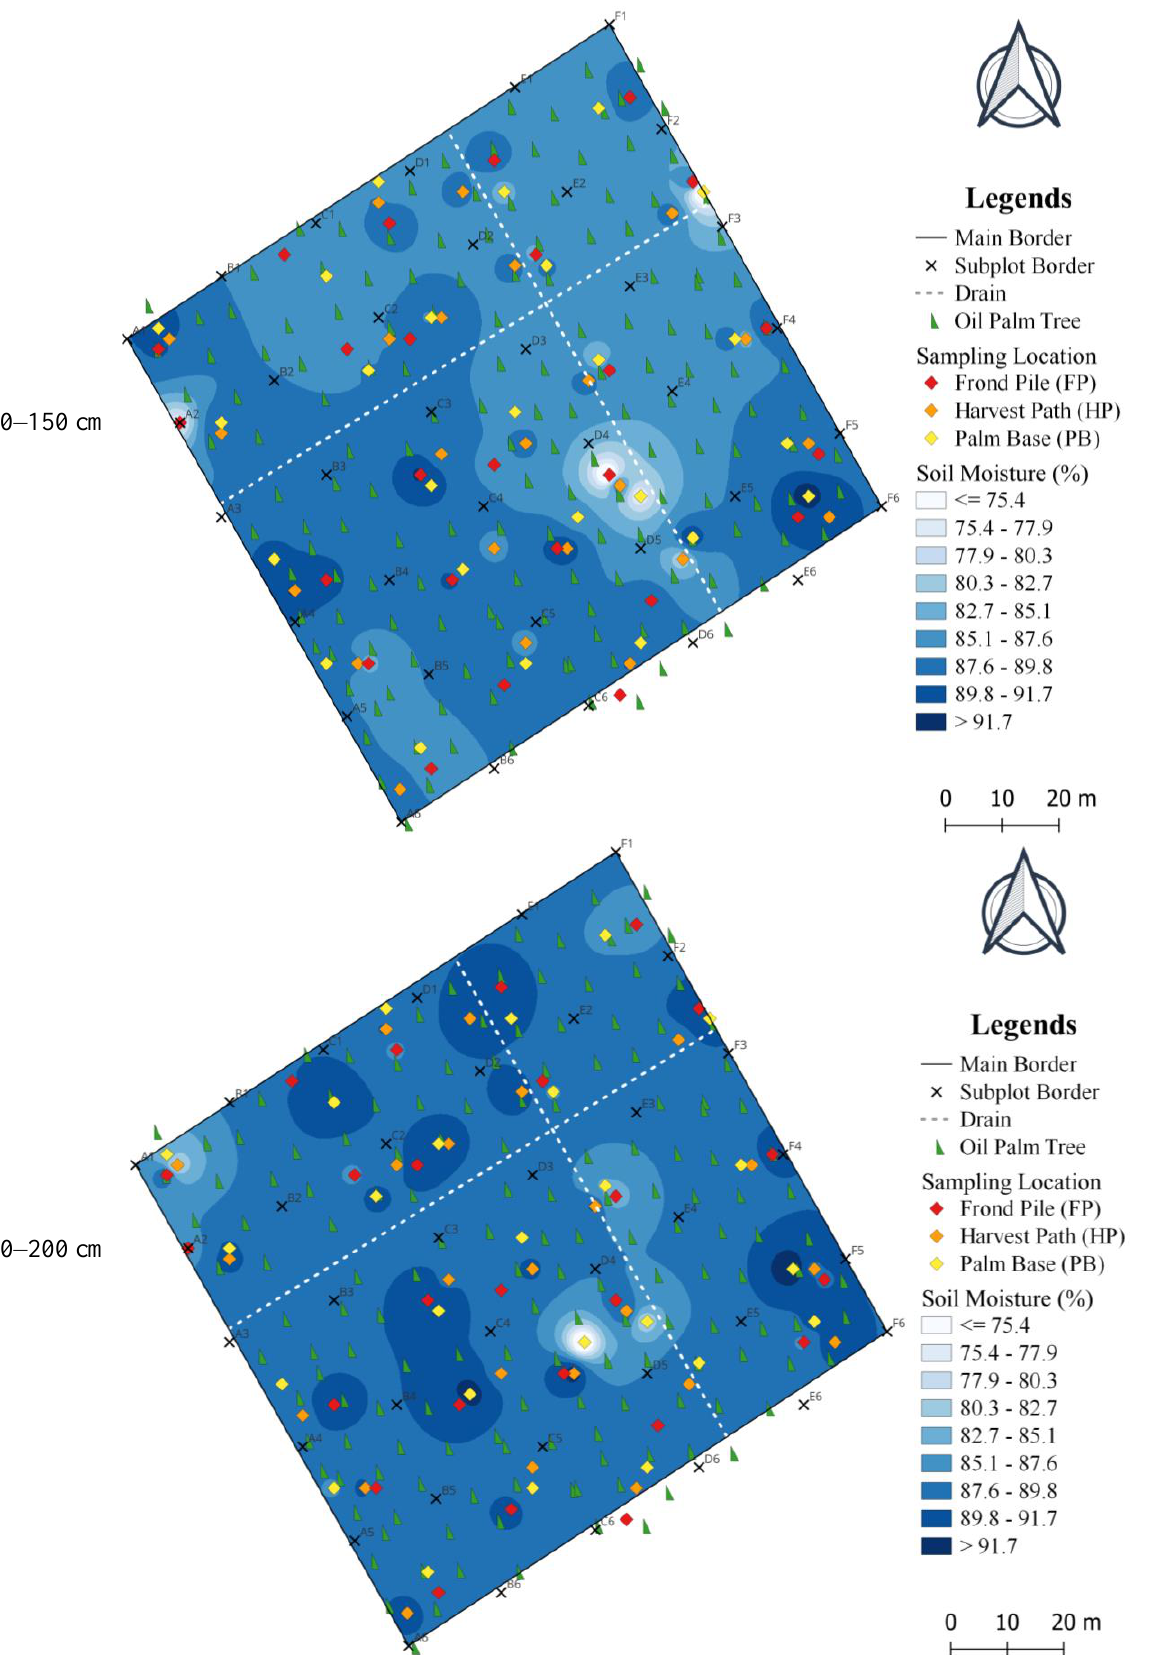
Figure 4. Maps showing the spatial distributions of subplots, sampling points, trees, drains and moisture content in deeper (100–150 cm and 150–200 cm) soil layers at Sebungan Estate oil palm